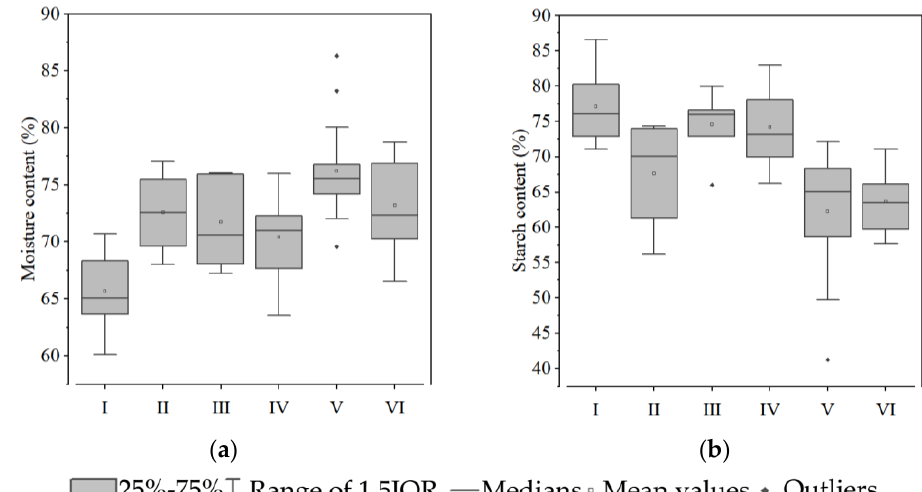
Figure 6. Moisture and starch content of the tuberous roots of six groups of sweet potato: ( a ) moisture content; and ( b ) starch content. White squares indicate mean values. Rhombuses indicate out- liers.